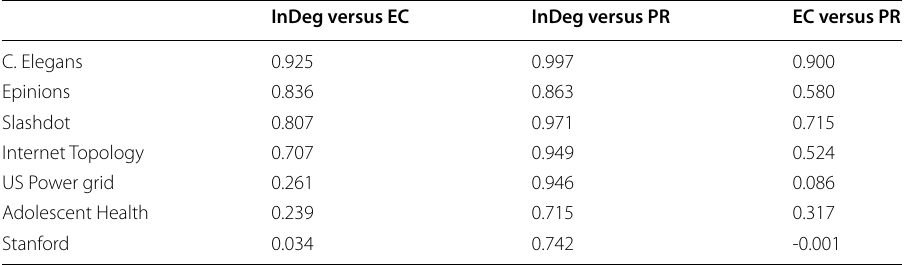
Table 2 Correlations between EC, PR and in‑degree for the various datasets used in the experimental section InDeg versus EC InDeg versus PR EC versus PR